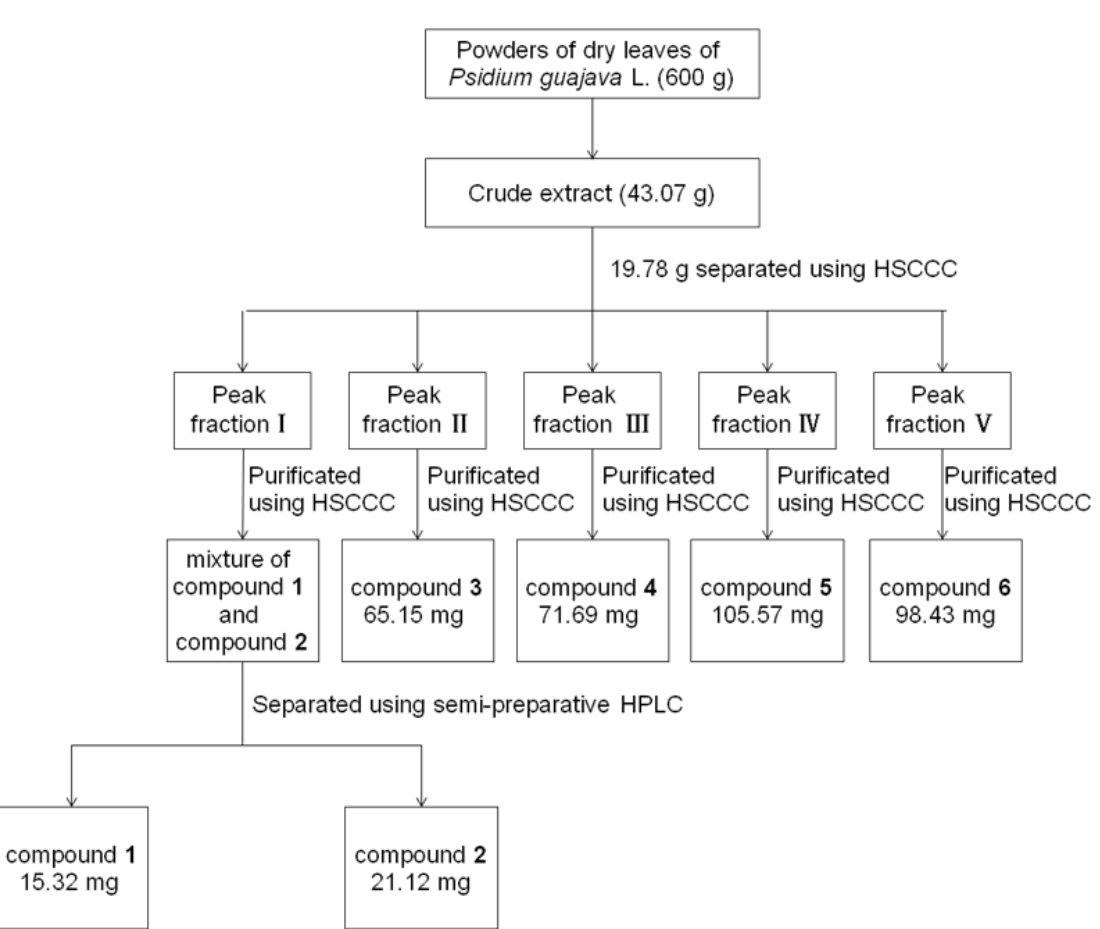
Figure 4. The sample preparation